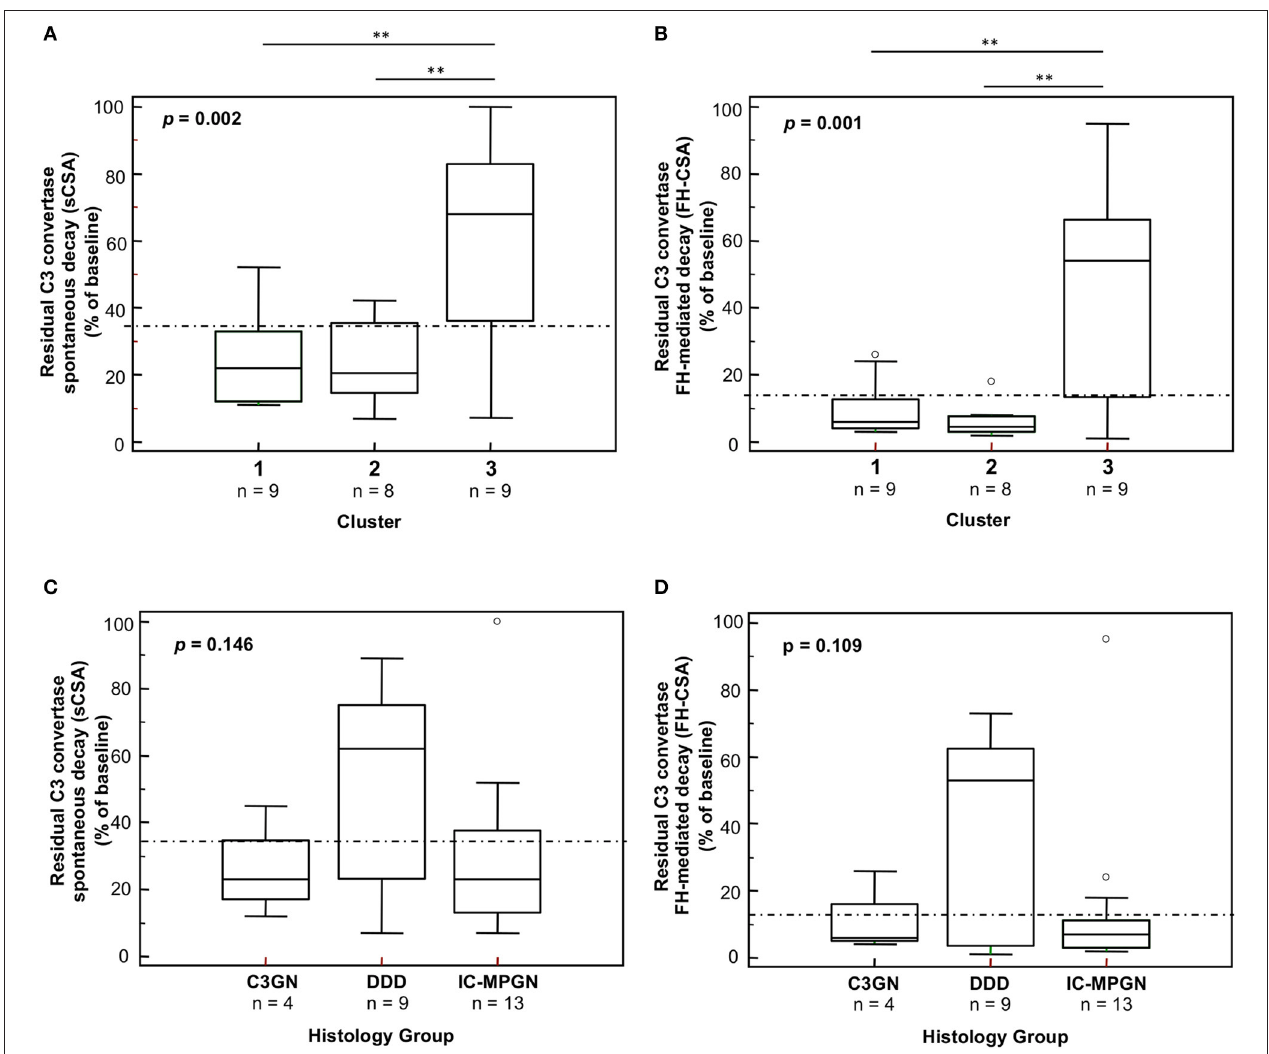
FIGURE 3 | Distribution of the C3NeF IgG C3 convertase-stabilizing activities in the absence of properdin according to the clusters and the histology groups. Box plots show significantly higher C3 convertase stabilizing activities against spontaneous (sCSA) and FH-mediated (FH-CSA) decay (protocol 1) in patients of cluster 3 than cluster 1 and 2 patients (A,B) . No significance difference was observed among histology groups (C,D) . The boxes represent the values from the 25th to 75th percentiles. The horizontal bars are the medians. Vertical lines are the 95% confidence intervals. Empty circles are values outside the 95% confidence intervals. The dashed horizontal lines show the limit of positive values (set at > mean + 2SD of results with control IgGs from 26 healthy subjects). ** P <